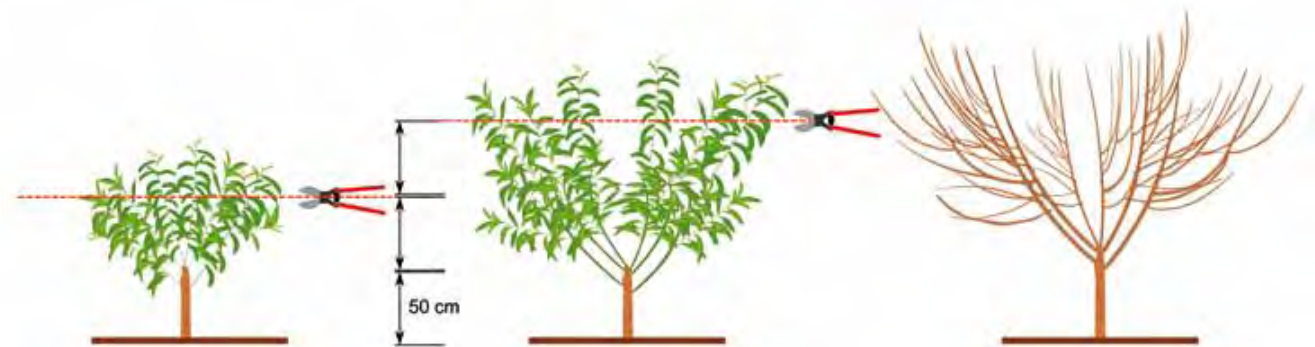
Fig. 6 - Catalonian vase during the first growing season. Left: first manual topping when the shoot exceeds 100 cm from the soil. Centre: second topping (manual or mechanical) when the shoots exceeds 150 cm from the soil. Right: the final growth at the end of the first year (redrawn from Monserrat and Iglesias,